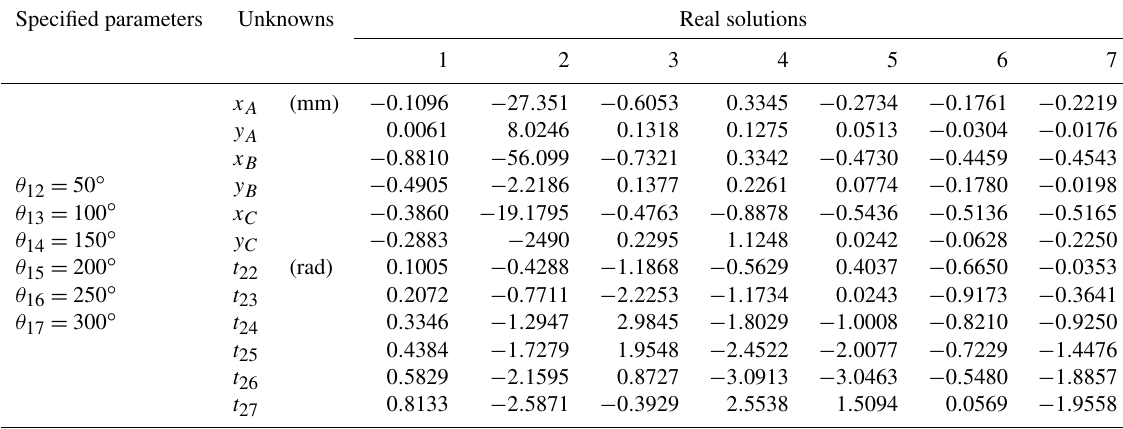
Table A3. Specified parameters and real solutions.